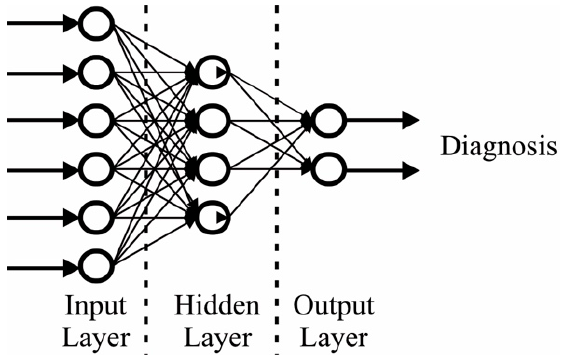
Figure 5. Artificial Neural Network.